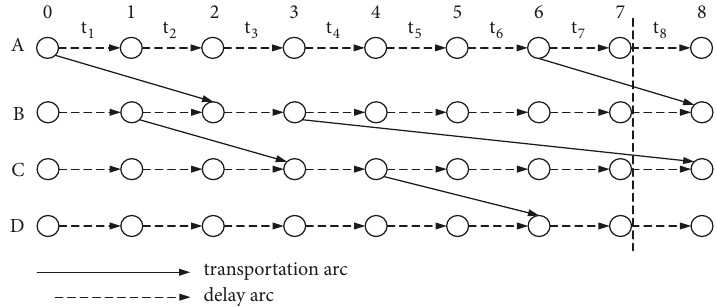
Figure 1: The time-space network of physical network for empty pallet